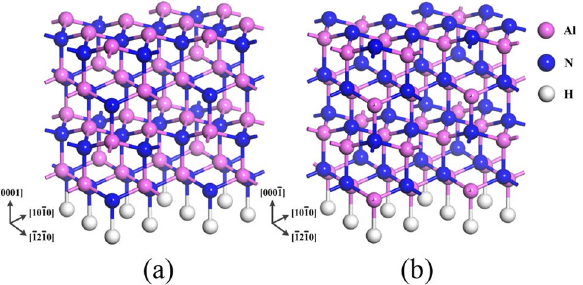
Figure 1. The models of (2 × 2) slab models with four AlN layers ( a ) AlN (0001) surface the top layer is Al atoms and ( b ) AlN (000 1 ) surface the top layer is N atoms. The bottom layer of these models is terminated with fictitious hydrogen atoms, where pink, blue and white spheres denote aluminum, nitrogen and hydrogen atoms, respectively.